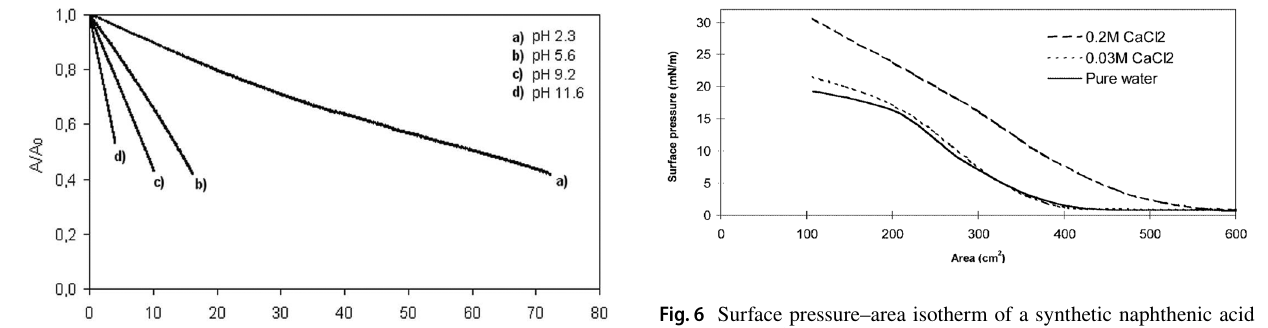
Fig. 6 Surface pressure–area isotherm of a synthetic naphthenic acid at different Ca 2+ concentrations (pH 5.6) (Havre et al. 2002)